Question: Give a one-sentence summary of this figure.
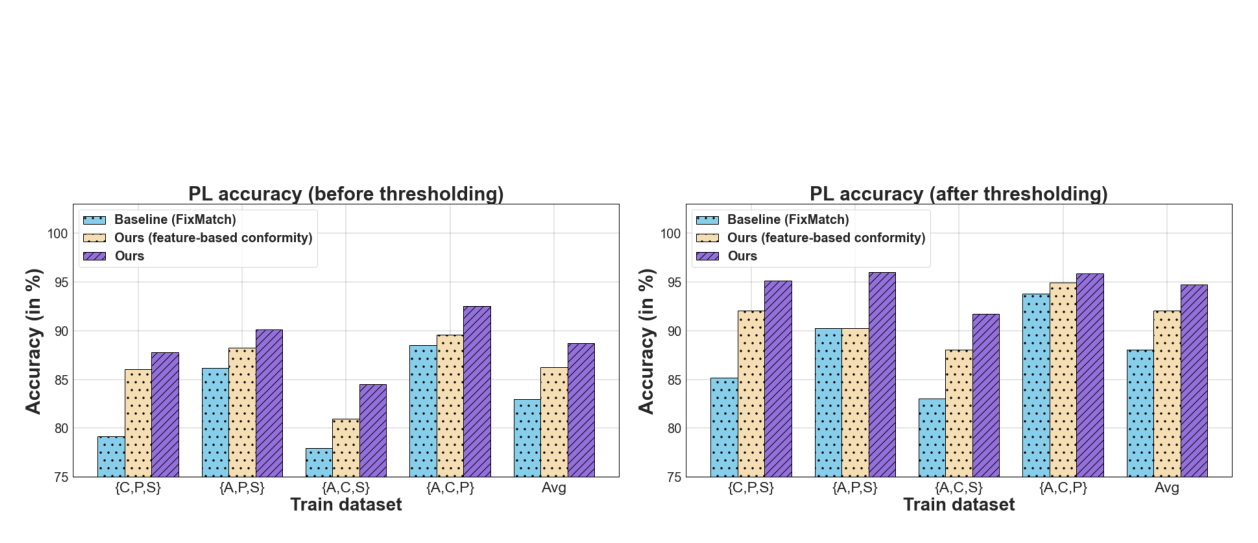
Answer: PL accuracy in the training samples without thresholding (left) and for selected PL after thresholding (right) for the baseline (FixMatch [32]), ours with only feature-based conformity, and ours for PACS dataset in 5 labels per class setting. Here A, C, P, and S denote Art-painting, Cartoon, Photos, and Sketch domains, respectively.